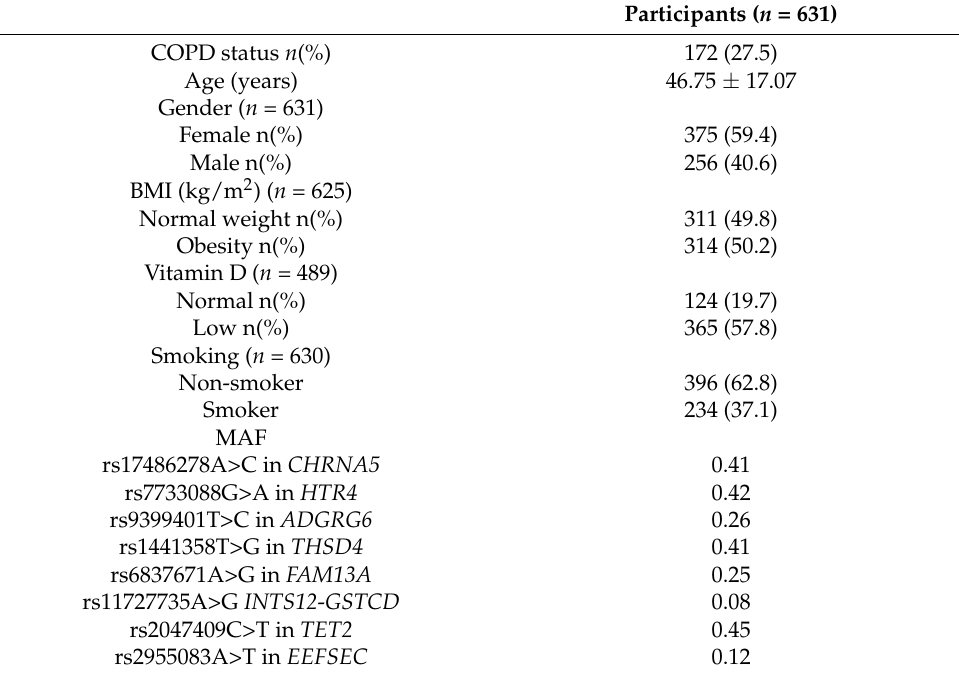
Table 1. Characteristics of the study